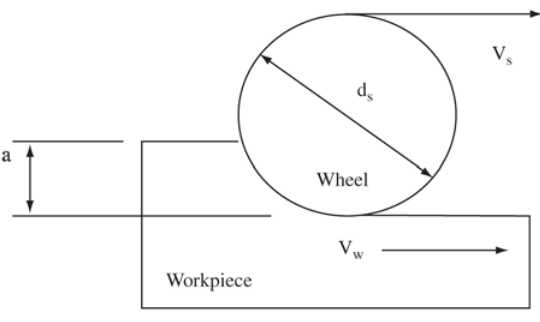
Figure 1. This figure shows the plunge grinding